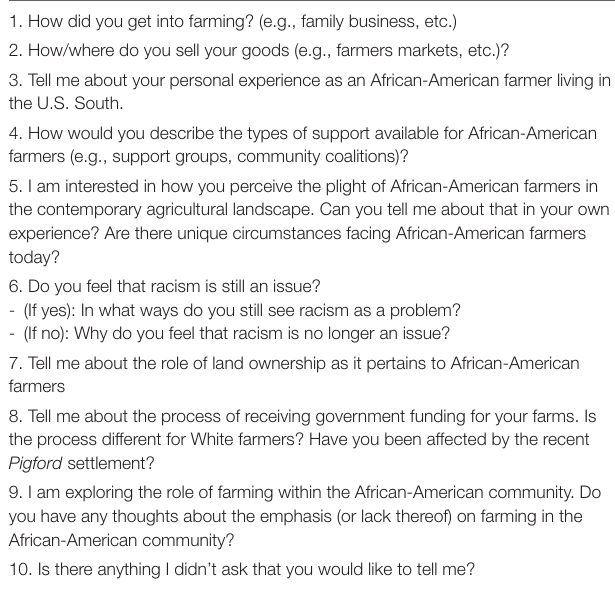
TABLE 2 | Questions from in-depth interview